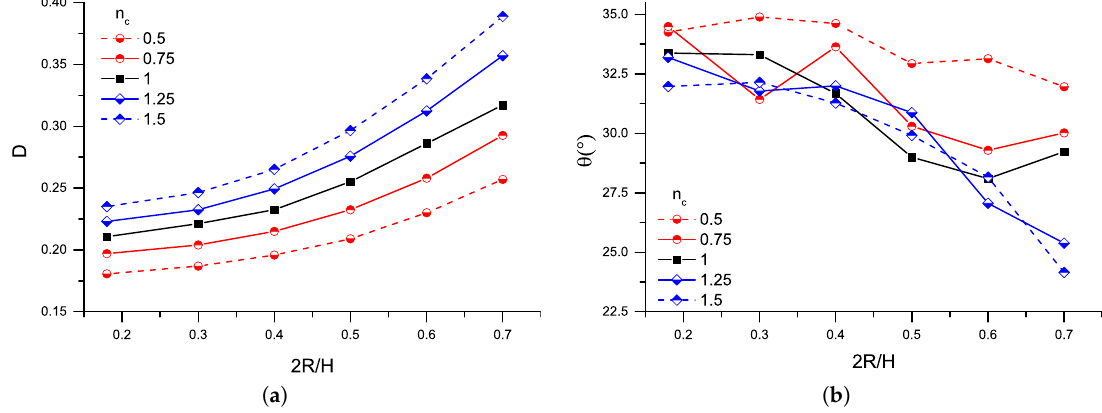
Figure 3. ( a ) deformation parameter; and ( b ) orientation angle as a function of the confinement ratio, 2 R / H , for a Newtonian droplet in a range of matrix fluids (Newtonian and power–law fluids, with power–law index n c ) at Ca = 0.2 and λ =